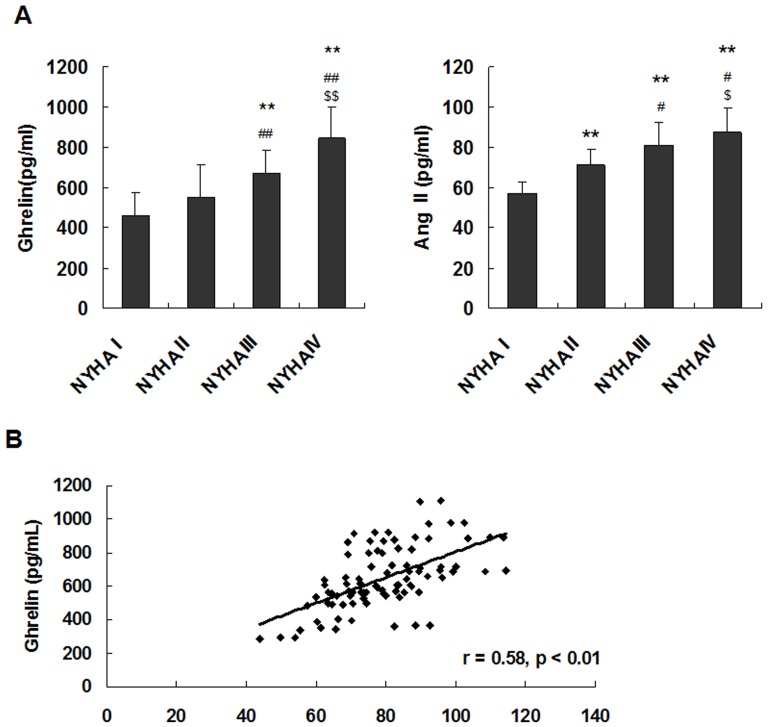
Ghrelin and Ang II were upregulated in patients with CHF.(A) Serum levels of ghrelin and Ang II in patients with CHF and in healthy subjects. (B) Correlation of ghrelin with Ang II in patients with CHF and in healthy subjects. The data are presented as the means ± SD. **P<0.01 vs. healthy control subjects (NYHAI); #P<0.05, ##P<0.01 vs. NYHA II; $P<0.05, $$P<0.01 vs. NYHA III.